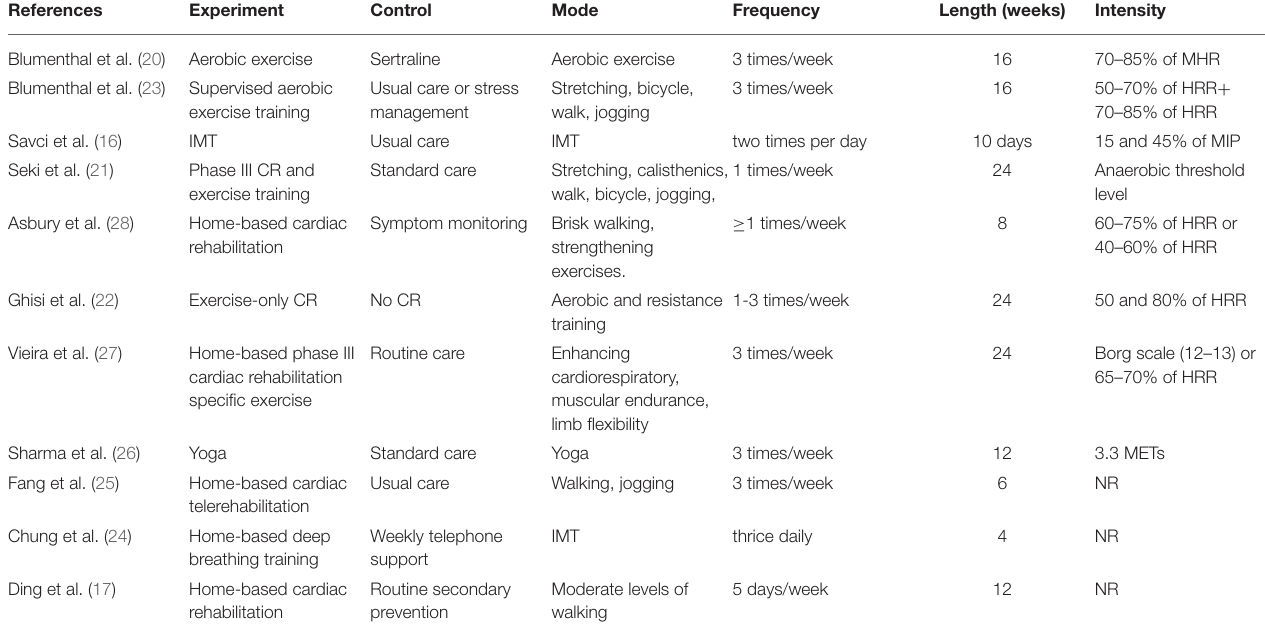
TABLE 2 | Characteristics of different exercise interventions.